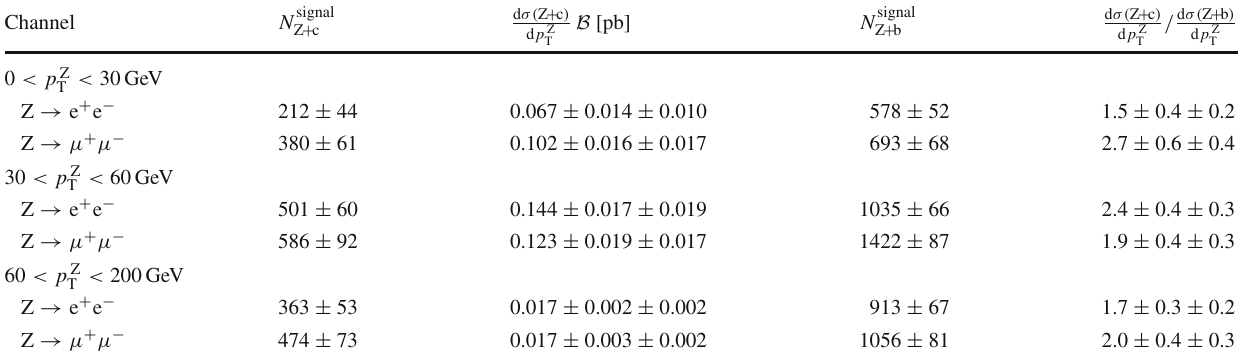
Table 2 Differential cross section d σ( Z + c )/ d p Z and in the two Z boson decay channels. The N signal yields of Z + c and Z + b events, respectively, extracted from the fit. All